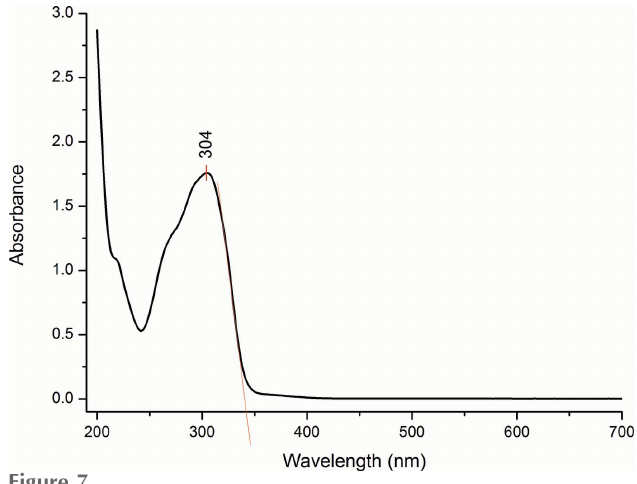
Figure 7 The UV–vis absorption spectrum of the title